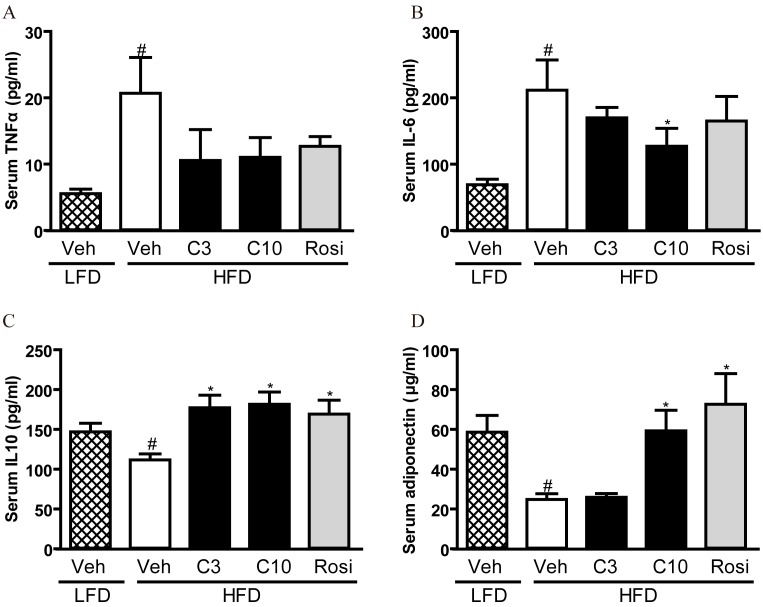
CMHX008 improves HFD induced systemic inflammation.C57BL/6 mice were fed with HFD or LFD for 16 weeks. Then HFD fed C57BL/6 mice were treated with CMHX008 (3 and 10 mg/kg, HFD-C3 and HFD-C10), rosiglitazone (3 mg/kg, HFD-Rosi) or vehicle (HFD-Veh or LFD-Veh) only, for additional 5 weeks. Trunk blood was collected at the end of the experiment. Serum was used for the measurement of TNF-α (A, IL-6 (B), IL-10 (C), and adiponectin (D). Data are the means ± S.E.M., n = 4–5; #
P<0.05 vs LFD-Veh and *P<0.05 vs HFD-Veh.